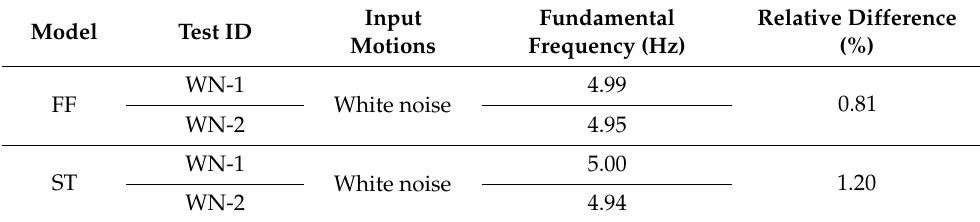
Table 6. Fundamental frequency of